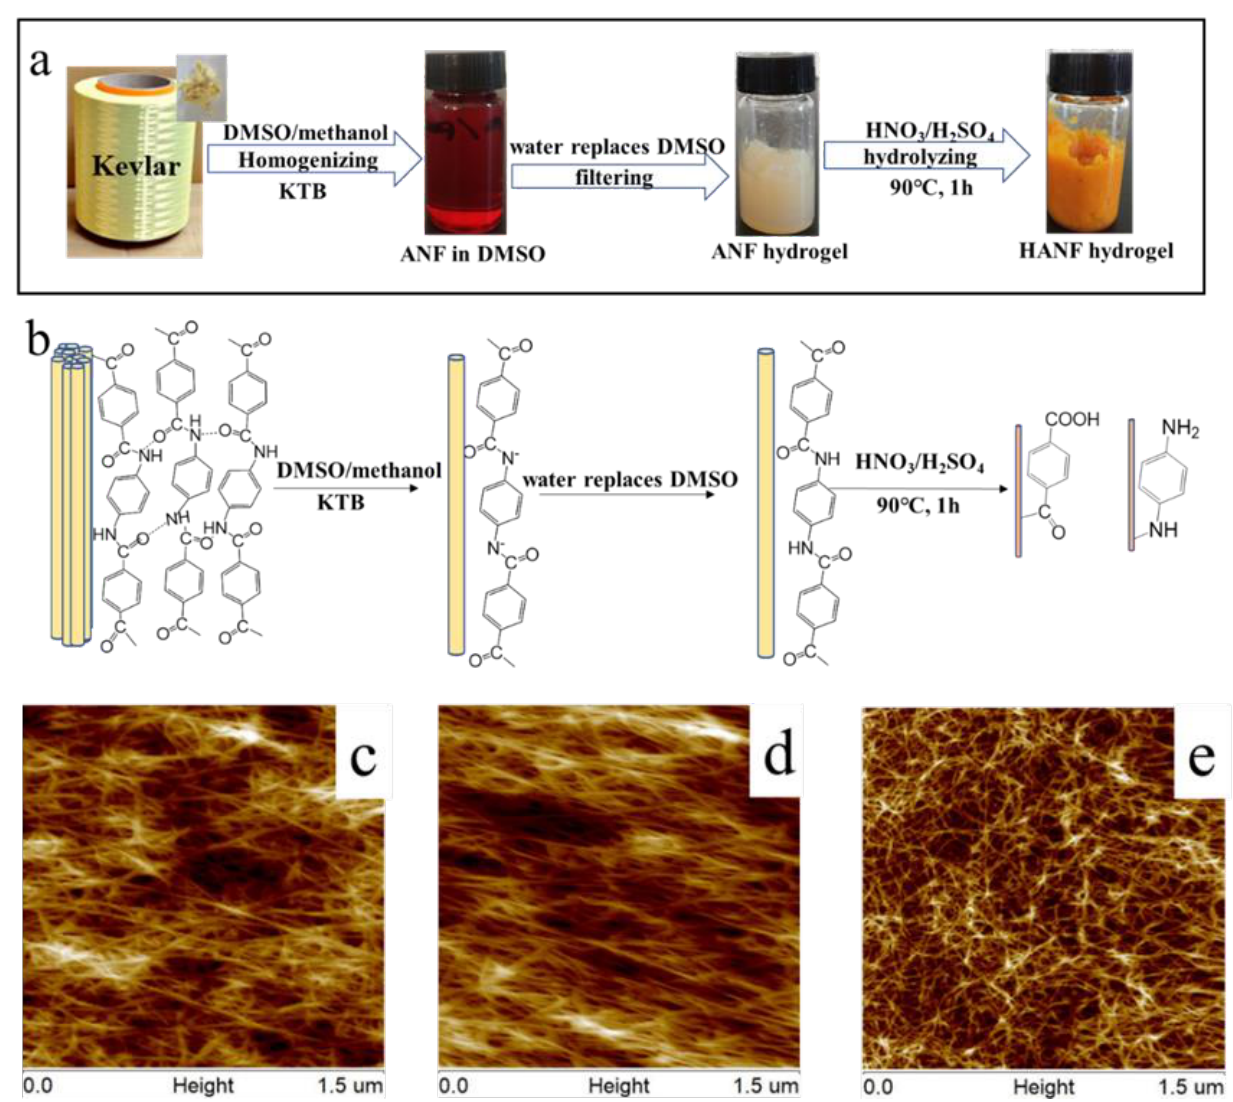
Figure 1. ( a ) Procedure to prepare an aramid nanofiber (ANF) solution and the hydrolyzed aramid nanofiber (HANF) hydrogel. ( b ) Synthetic mechanism leading to the ANF solution and HANF hydrogel. ( c – e ) AFM images of ANF in DMSO solution ( c ), ANF hydrogel ( d ), and HANF hydrogel ( e ).